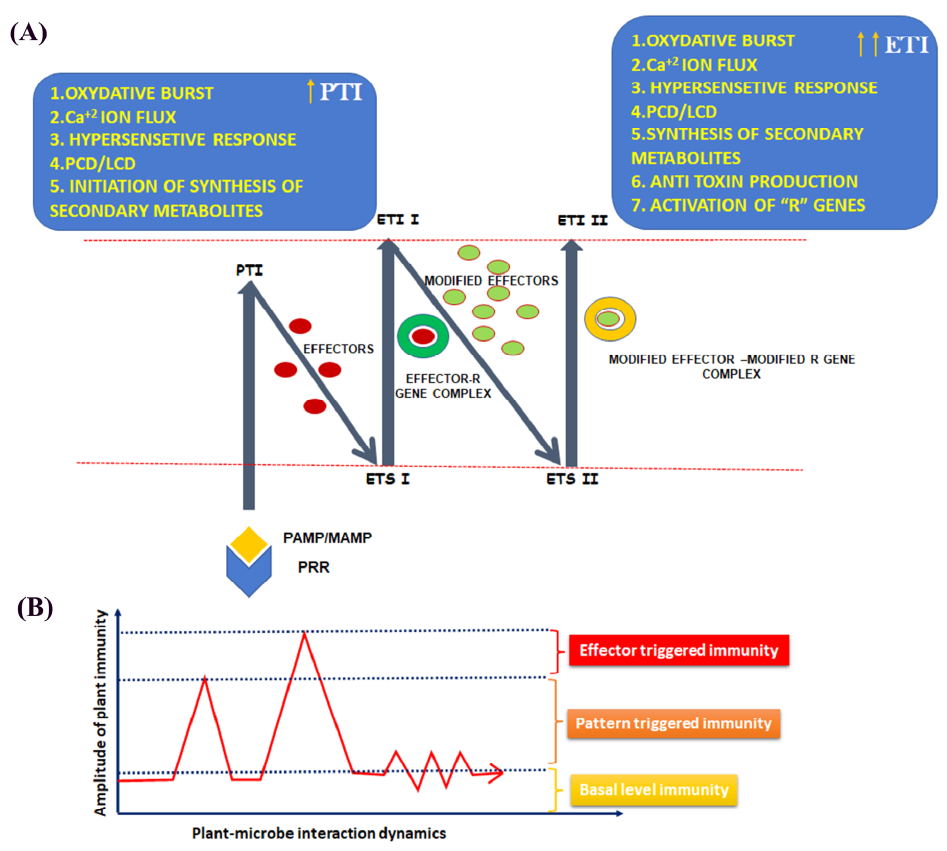
Figure 1. Schematic representation of plant immune response against pathogens. ( A ) Representation of the classical “zig-zag” model of the plant immunity. Pathogen-associated molecular patterns (PAMPs)/microbe-associated molecular patterns (MAMPs), when interacting with cognate host receptors (PRRs), instigate the first line of defence response called PAMP-triggered immunity (PTI). Pathogens then produce specific effector molecules or toxins that subside the PTI to the basal level, called effector-triggered susceptibility (ETS; I). Plants possess the “R” gene that produces antitoxins or inhibitors of toxins produced by the pathogens, and a second line of defence response is initiated, called effector-triggered immunity (ETI). Some pathogens can produce modified effectors to re-establish the ETS (II). This arms race continues, until one wins. ( B ). Graphical representation of the amplitude of the immune response in plants. The PTI induces sharp induction over the basal resistance response, but the amplitude of the ETI supersedes all, as it is the most specific against pathogens among